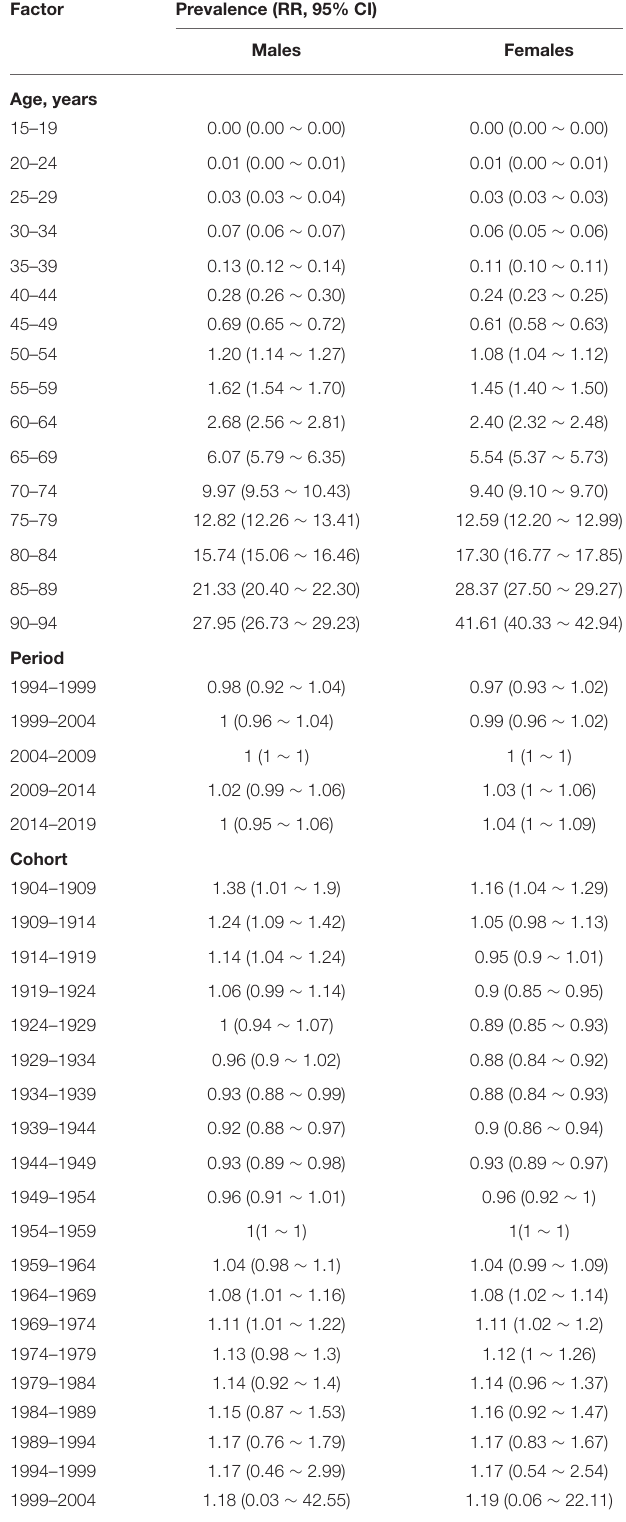
cohort of the model, respectively; µ denotes the intercept of the TABLE 2 | Hypertensive heart disease prevalence relative risk (RR) due to age, period, and cohort effects. model; and ε i denotes the residual of the Factor Prevalence (RR, 95% CI) Males Females